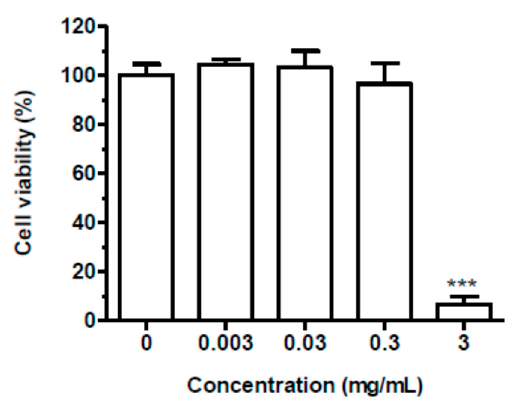
Figure 5. Cytotoxicity of spent coffee extract in HaCaT cells. Cells were treated with various concentrations of spent coffee extract (0.003–3 mg/mL) for 24 h. At the end of treatment, cell viability was evaluated by MTT assay, as described in the method section. Data are expressed as a percentage of control cells and expressed as mean ± SEM of three independent experiments (*** p < 0.001 vs. cells untreated; one-way ANOVA with Dunnett post hoc test).